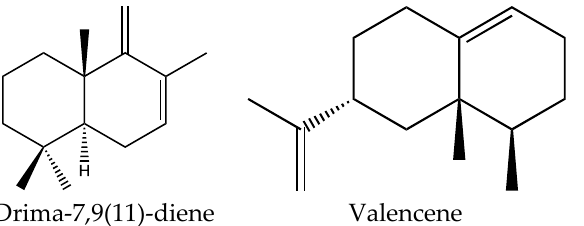
Figure 3 . The main compounds identified in essential oils from Turnera diffusa extracted by eco-friendly methods.